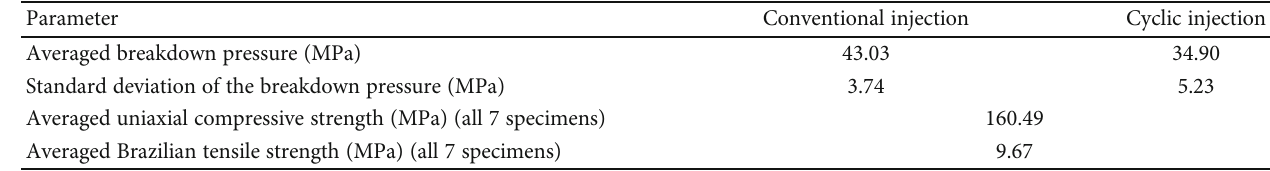
Table 2: Some average results for the fi rst batch of sandstone.